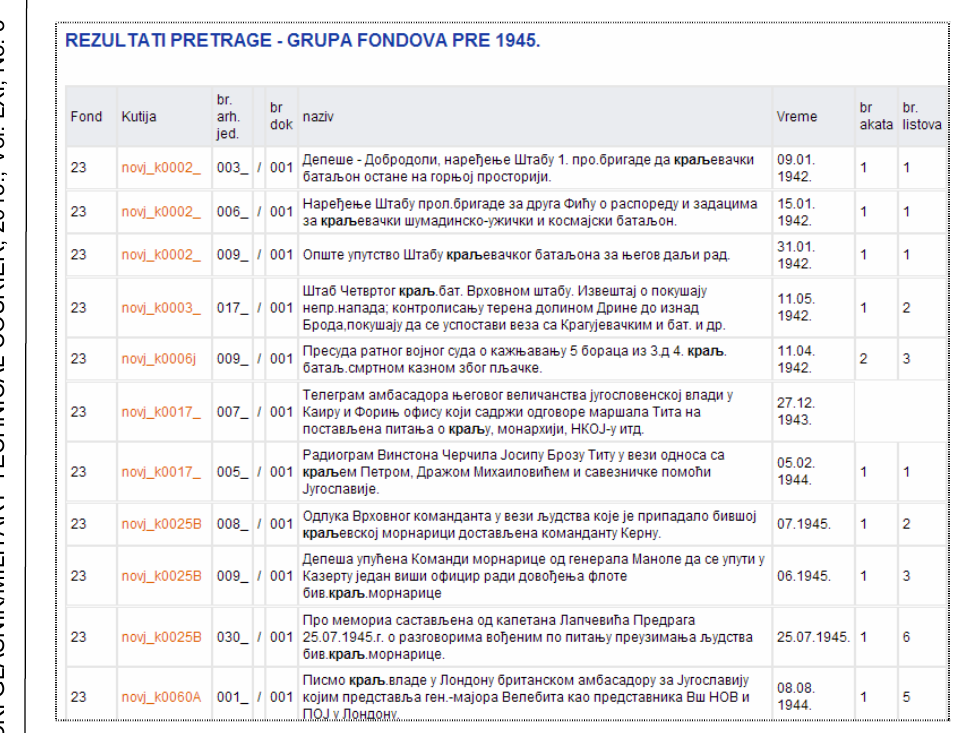
Prilikom pretrage na bilo koji od opisana dva na č ina otvara se digi- talizovani dokument kao na slici 16. Dokument se nalazi sa leve strane, uz mogu ć nost biranja broja strane dokumenta za pregled ili uve ć anja ili smanjenja pregleda. Sa desne strane nalaze se osnovne informacije o dokumentu: kratak sadržaj dokumenta, vreme nastanka i broj strana. Is- pod osnovnih podataka nalazi se boks u kojem istraživa č može da iza- bere dokument za štampanje ili za snimanje na neki od medijuma. Isto tako, može se uneti i broj strana koje su od interesa ako istraživa č ne želi kompletan dokument. U donjem desnom delu nalazi se i lista svih dokumenata koja pripadaju istoj grupi i kojima istraživa č može direktno pristupiti. Na ovaj na č in istraživa č ima je olakšan pristup dokumentima koji su povezani sa otvorenim dokumentom i jednostavnije istraživanje grupe